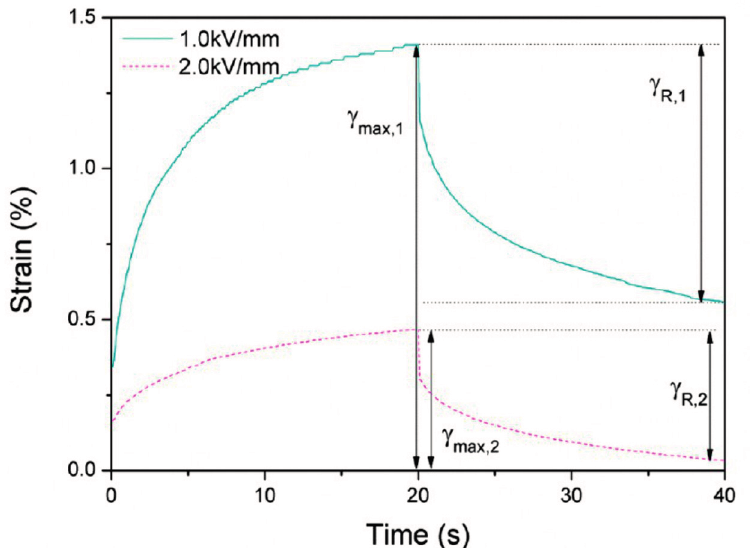
Figure 8. Creep and recovery test for PSBM/SiO 2 based ER fluid (Reprinted with permission from [87], copyright 2014 American Chemical